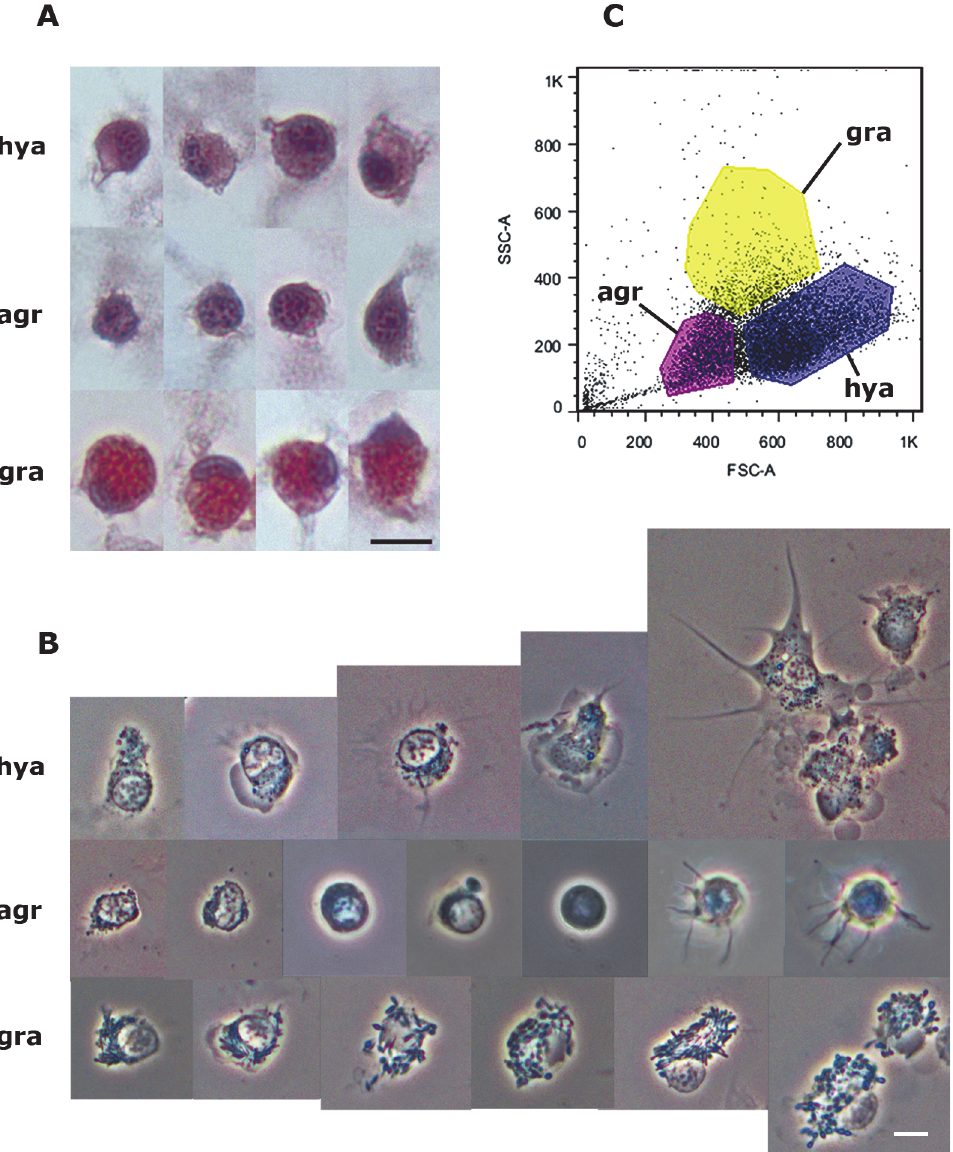
Fig 1. Circulating hemocyte types and their separation by flow cytometry. (A) Examples of hyalinocytes, agranulocytes and granulocytes in hemolymph smears (HE-stain). (B) Examples of living hyalinocytes, agranulocytes and granulocytes attached onto a glass slide (phase contrast). (C) Flow cytometry (dot plot of size vs . complexity-granularity) of a representative hemolymph sample indicating the three areas that were chosen for cell sorting, where the three hemocyte types were predominant. Abbreviations: agr , agranulocytes; gra , granulocytes; hya , hyalinocytes. Scale bars represent 5 μ